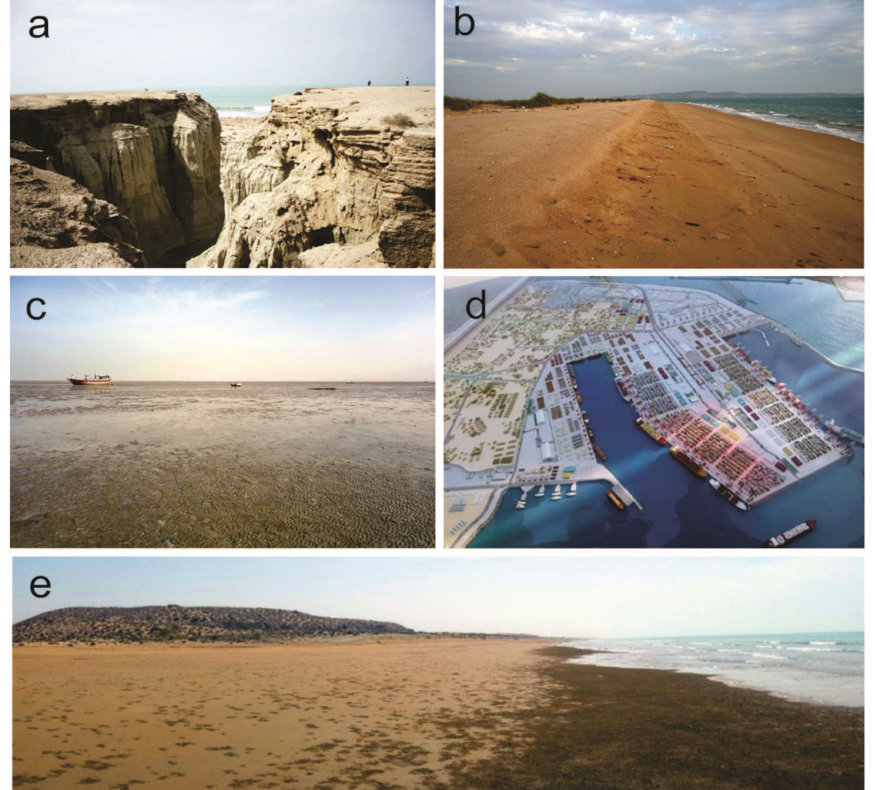
Figure 3. Some characteristic geomorphological features of the Iranian coast of Makran. ( a ) Uplifted marl and sand formations undergoing intensive erosion. ( b ) Sandy beach. ( c ) Tidal flat. ( d ) Man-made coast. ( e ) Coastal sand